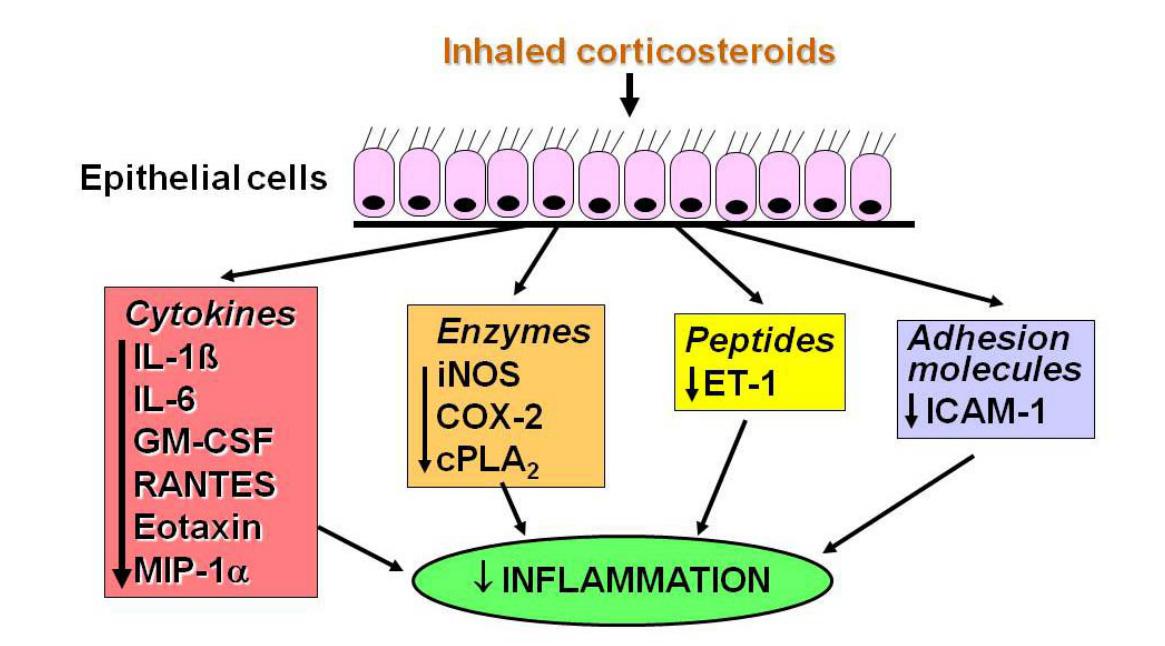
Figure 2. Inhaled corticosteroids may inhibit the transcription of several inflammatory genes in airway epithelial cells and thus reduce inflammation in the airway wall. NF- κ B = nuclear factor κ B; AP-1 = activator protein-1; GM-CSF = granulocyte-macrophage colony stimulating factor; IL-1 = interleukin-1; iNOS = inducible nitric oxide synthase; NO = nitric oxide; COX-2 = inducible cyclooxygenase; cPLA PG = prostaglandin; ET = endothelin; ICAM = intercellular adhesion